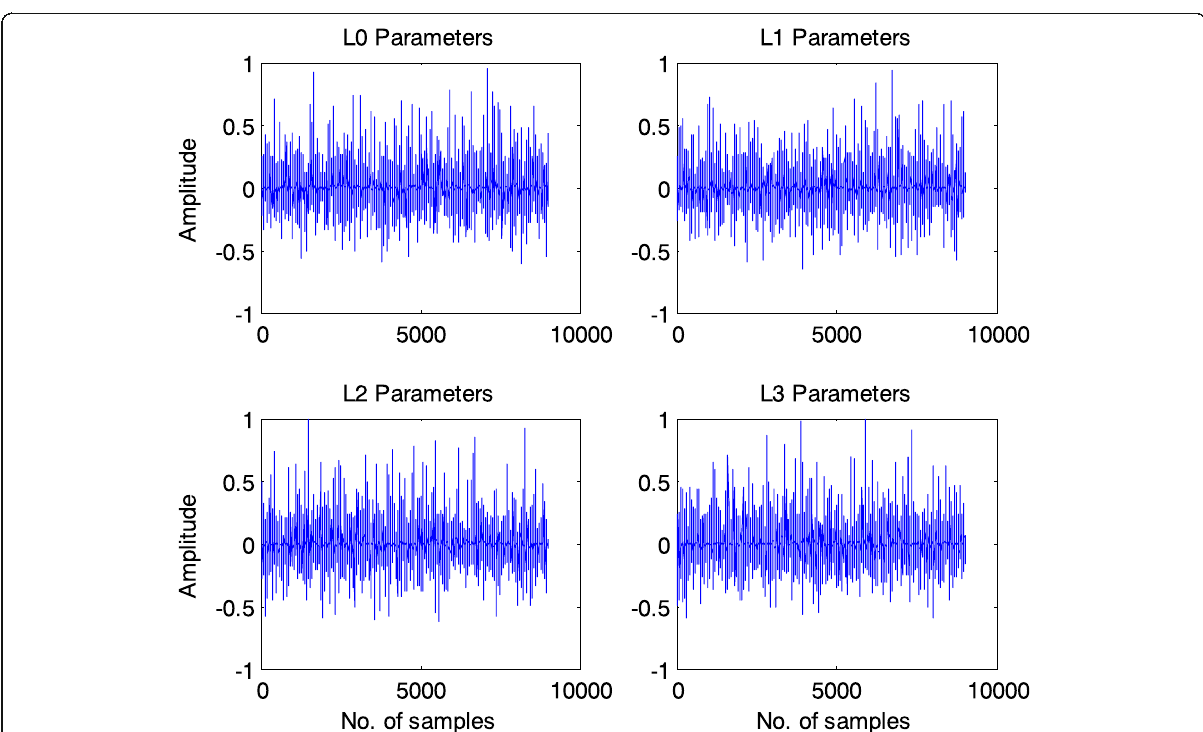
Fig. 5 Histogram of splitted signals L 0 , L 1 , L 2 , and L